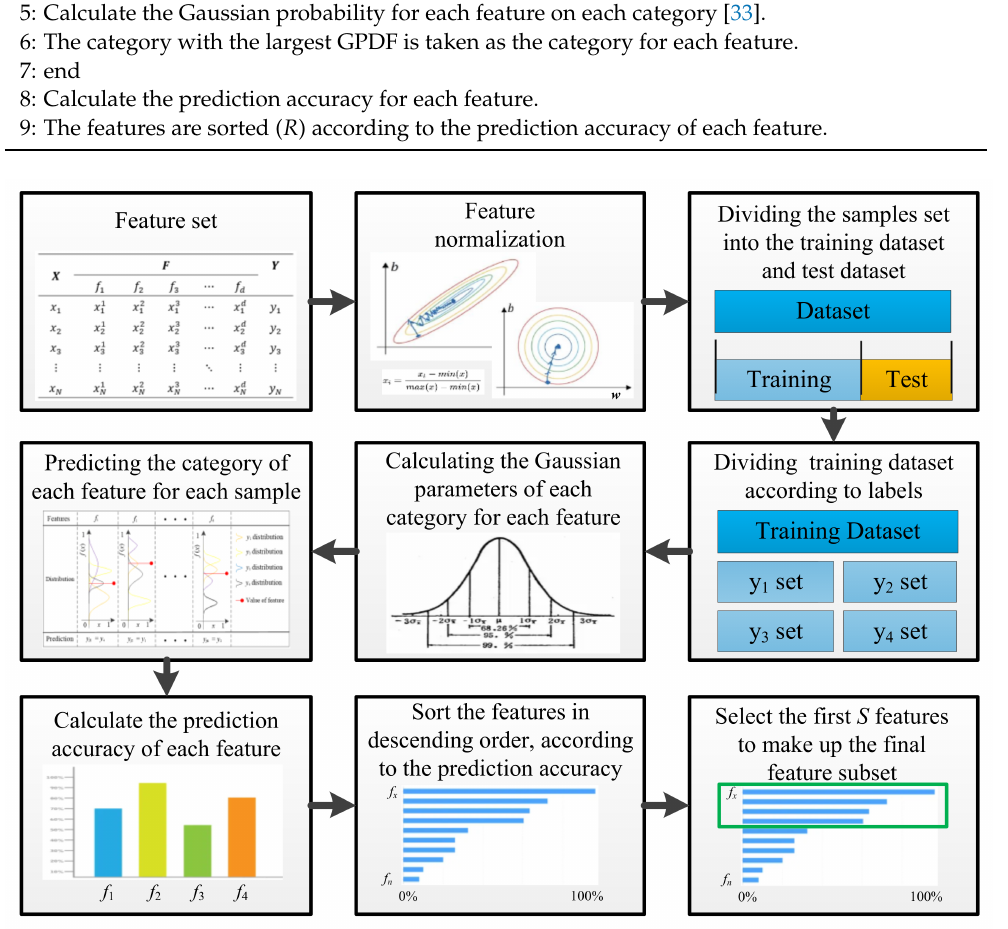
Figure 3. The process of the proposed GVFS